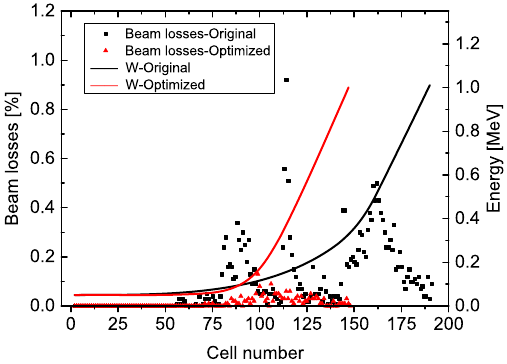
FIG. 6. The beam losses and energy change with a cell number in the original and optimized designs.